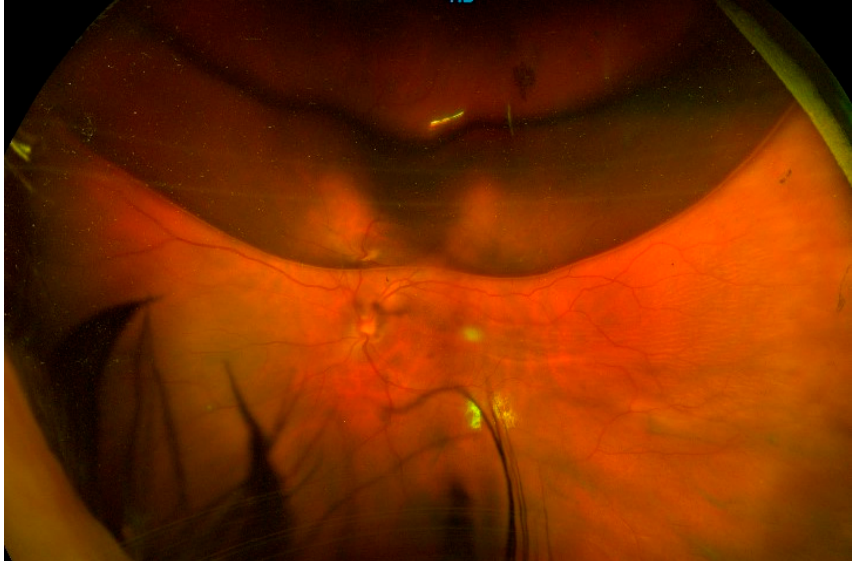
Figure 2. Post-operative day 1. The retinography shows a 40% filling of